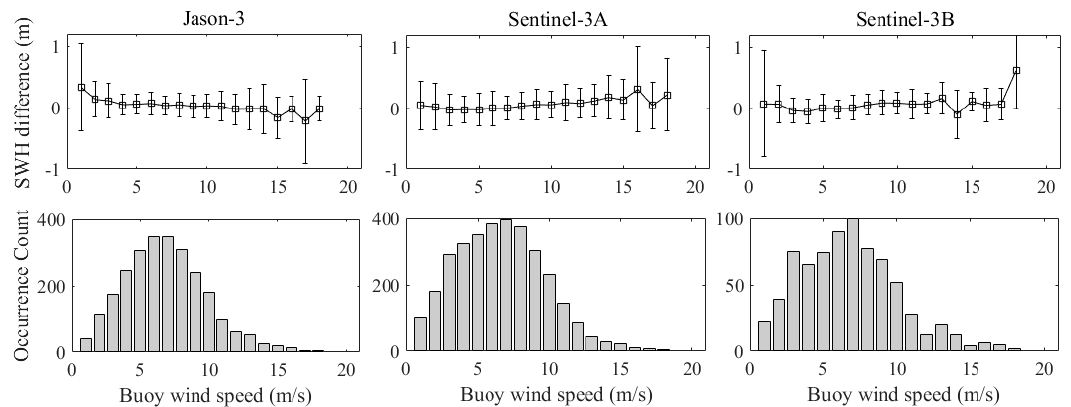
Figure 13. Dependence of the statistical parameters of SWH differences between the Jason-3, Sentinel-3A, and Sentinel-3B altimeters and the NDBC buoys on buoy WS.